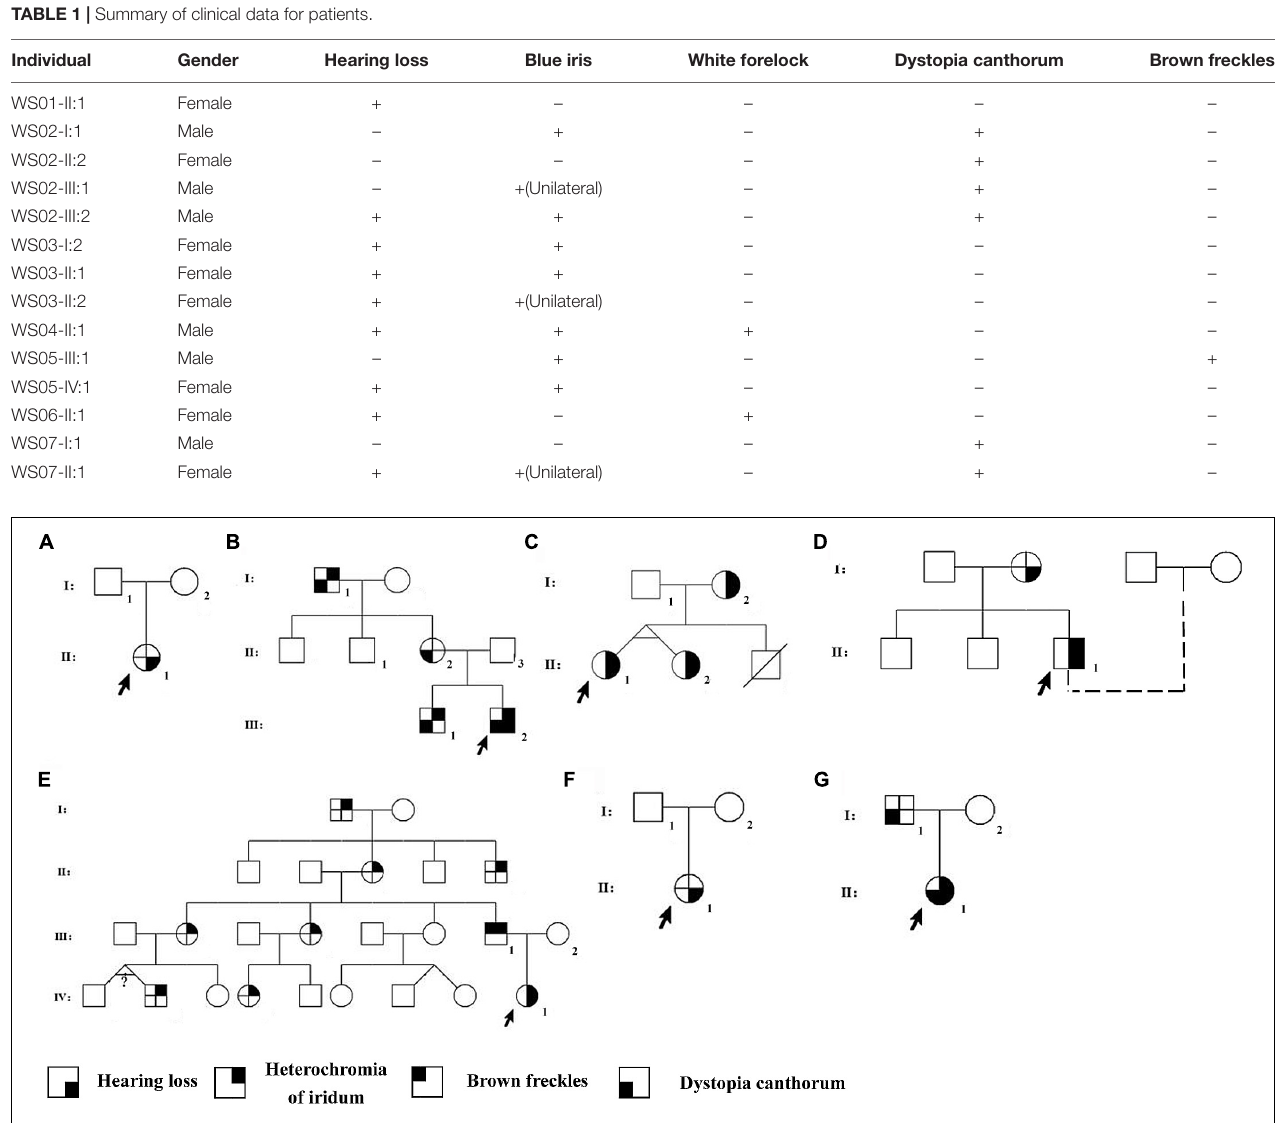
FIGURE 1 | Pedigrees of the Waardenburg syndrome families. Pedigrees of families Individuals with a number assigned participated in the current study. Phenotypes of the rest of the family members were based on the relative’s description. The probands were pointed by arrows. (A) WS01, (B) WS02, (C) WS03, (D) WS04, (E) WS05, (F) WS06, and (G)